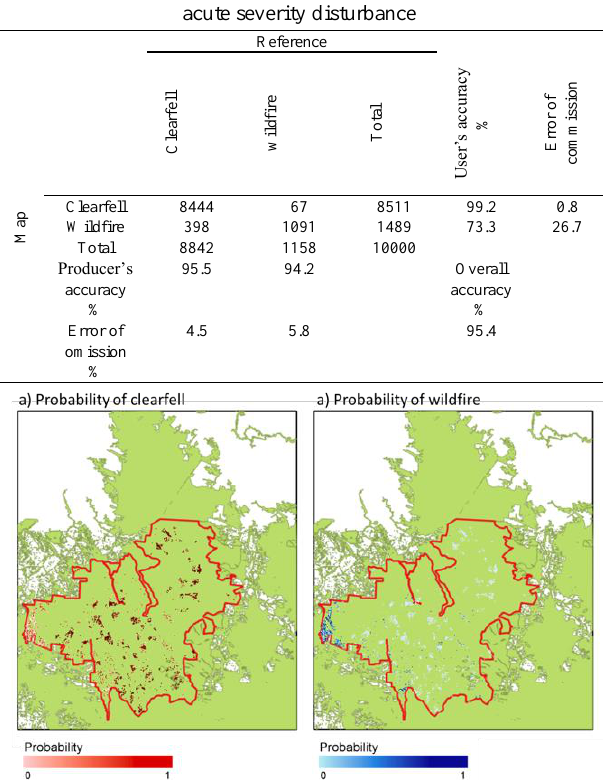
Figure 6: Mapped probability of (a) clearfell and (b)